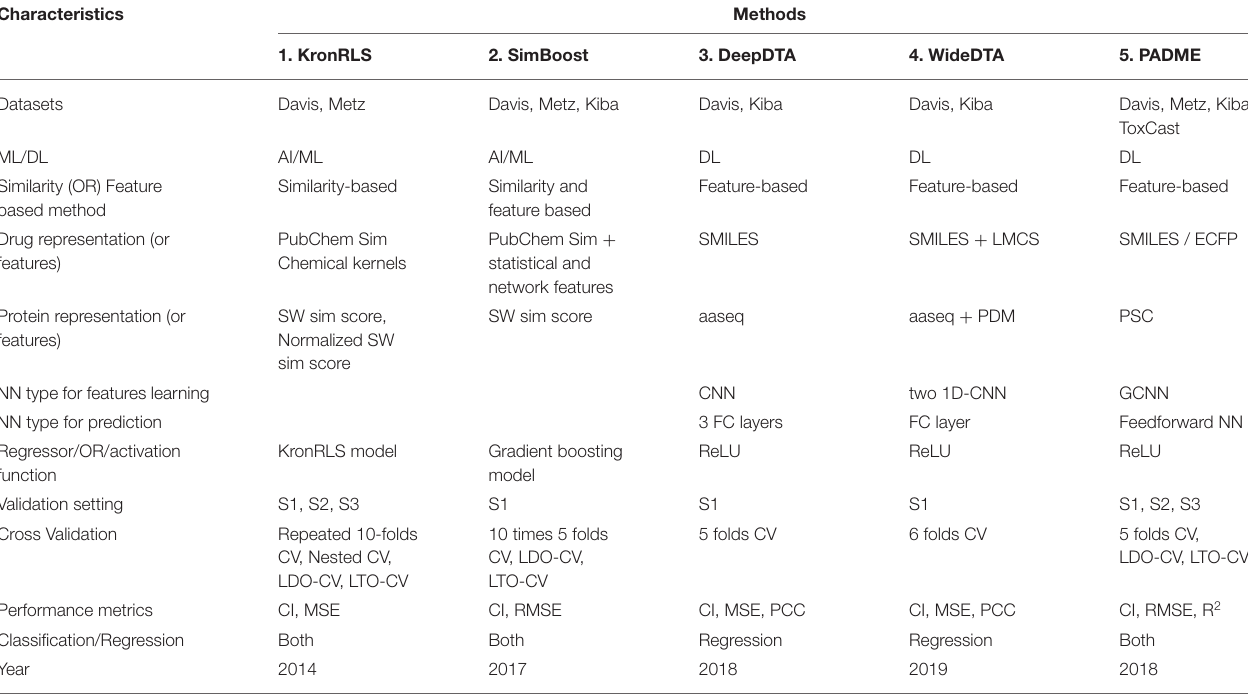
TABLE 4 | Baseline methods